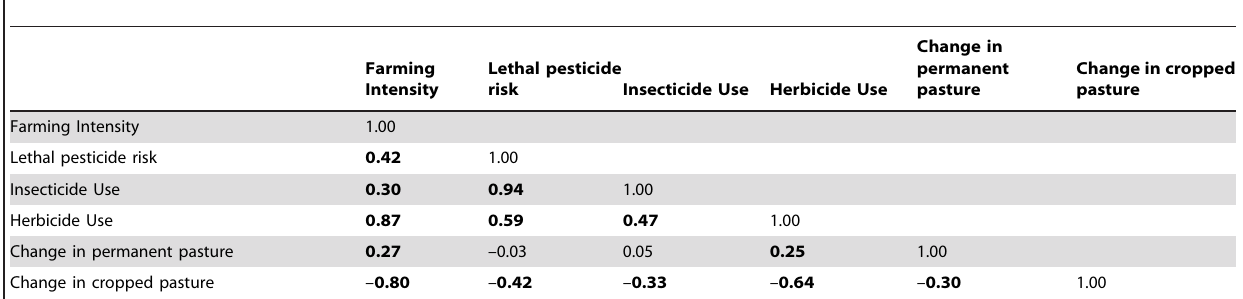
Table 3. Correlation matrix of predictor variables. Significant (P , 0.05) correlation coefficients are shown in bold.